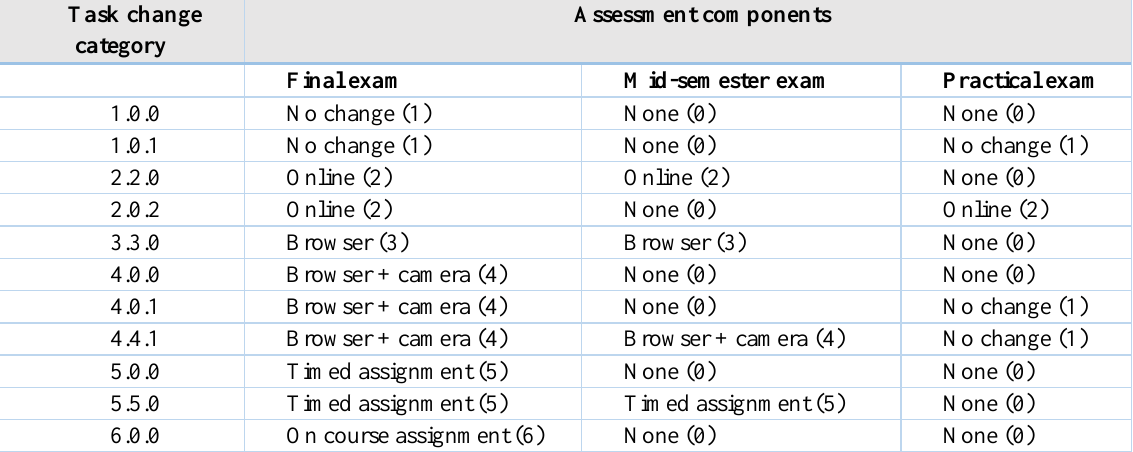
Task Change Categories Employed During the Shift to Online Assessment in Response to COVID-19 Task